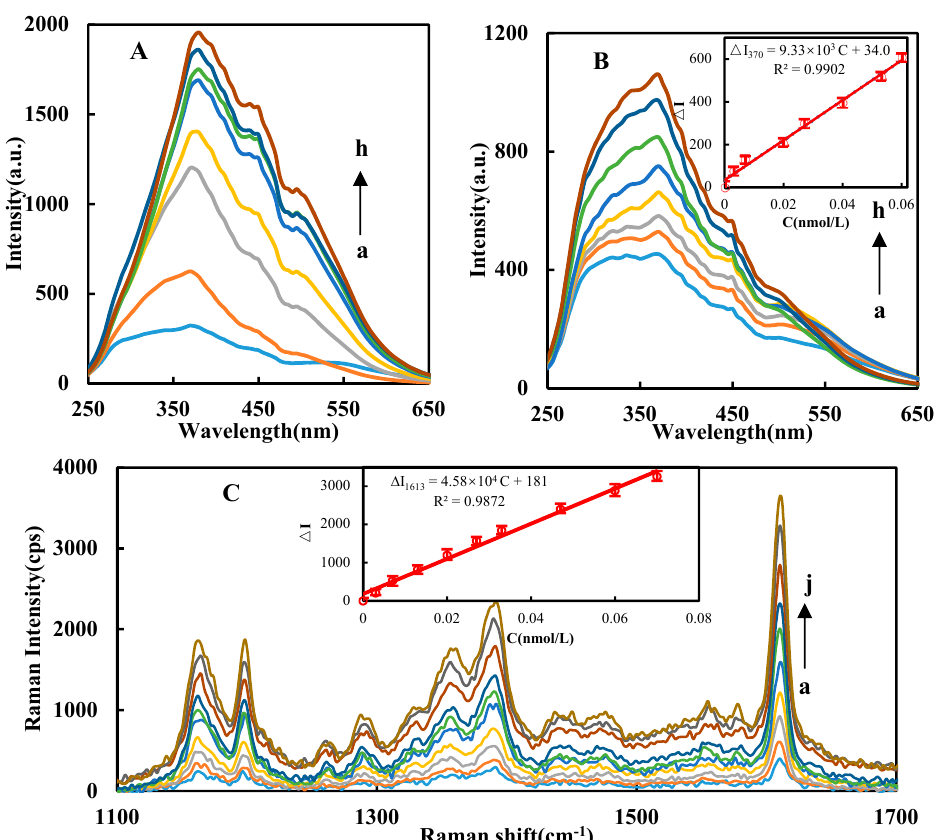
Figure 3. RRS and SERS spectra of the catalytic analysis system. ( A ) RRS spectra of catalytic system: 53.0 mg/L HAuCl 4 + 0.300 mmol/L HCl + 2.00 g/L PEG600+ DdBd (a–h: 0, 0.225, 0.450, 0.675, 0.900, 1.13, 1.35, 1.58 mmol/L DdBd). ( B ) RRS spectra of catalytic analysis system: 0.080 g/L HAuCl 4 + 0.230 mmol/L HCl + 2.00 g/L PEG600 + 0.450 mmol/L DdBd + 6.70 pmol/L Apt + OTC (a–h: 0, 3.00 × 10 − 3 , 6.70 × 10 − 3 , 2.00 × 10 − 2 , 2.70 × 10 − 2 , 4.00 × 10 − 2 , 5.30 × 10 − 2 , 6.00 × 10 − 2 nmol/L OTC). Inset shows a linear relationship between the RRS intensity( △ I 370 ) with the OTC concentration. ( C ) SERS spectra of catalytic analysis system: 0.080 g/L HAuCl 4 + 0.230 mmol/L HCl + 2.00 g/L PEG600 + 0.450 mmol/L DdBd + 6.70 pmol/L Apt OTC +0.625 µ mol/L VBB+OTC (a–j: 0, 3.00 × 10 − 3 , 6.70 × 10 − 3 , 1.30 × 10 − 2 , 2.00 × 10 − 2 , 2.70 × 10 − 2 , 3.30 × 10 − 2 , 4.70 × 10 − 2 , 6.00 × 10 − 2 , 7.00 × 10 − 2 nmol/L OTC). Inset shows a linear relationship between the SERS intensity( (cid:52) I 1613 ) with the OTC